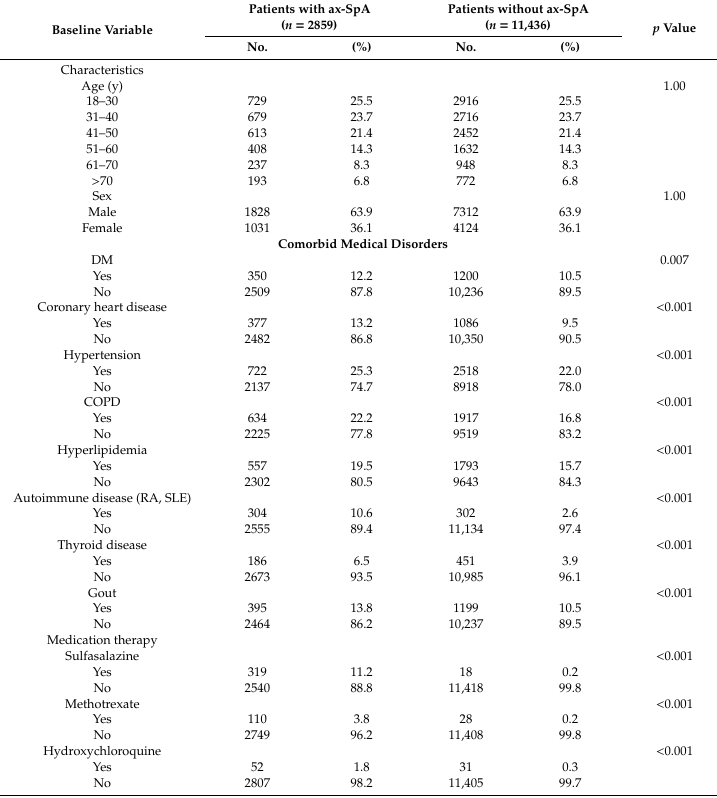
Table 1. Baseline demographic characteristics and comorbidities for age- and sex-matched patients in the ankylosing spondylitis and non-ankylosing spondylitis cohorts ( n = 14,295). Patientswithax-SpA Patientswithoutax-SpA ( n = 2859) ( n = BaselineVariable